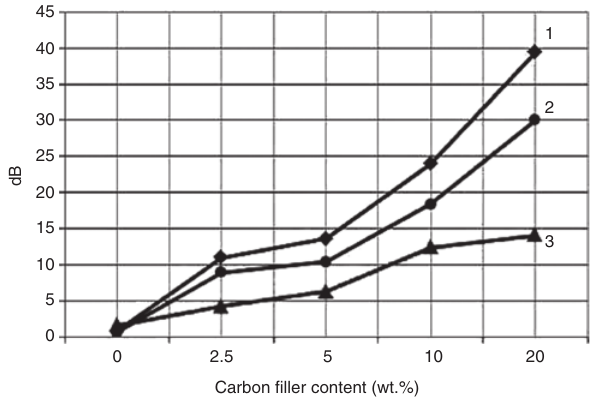
Figure 5: Dependence of attenuation losses (1), absorption losses (2) of EMR and of VSWR (3) on the content of carbon fillers in UHMWPE- based composites. EMR frequency at measurements was 4